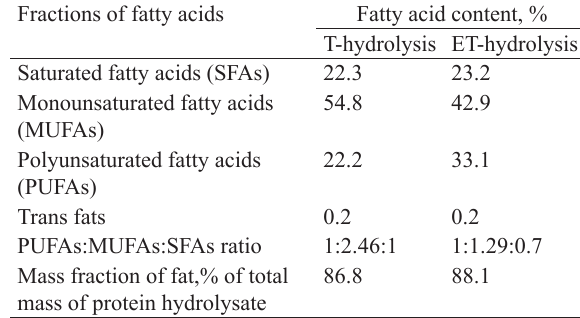
Table 5 Fractional composition of fats in protein hydrolysates from sockeye heads after thermal and enzymatic-thermal hydrolysis Fractions of fatty acids